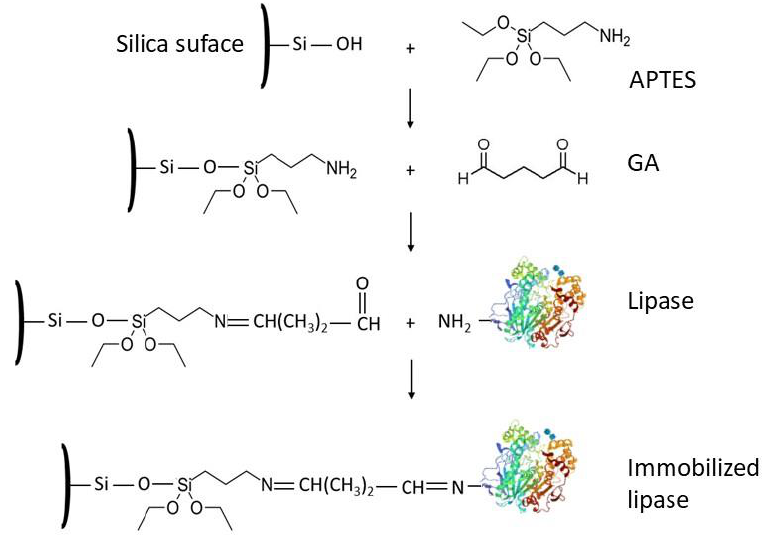
Figure 10. Lipase immobilization on epoxy-functionalized SBA-15. The application of magnetic nanoparticles in enzyme immobilization has received a great deal of attention due to the cheap and easy synthesis and better enzyme perfor- mance in recovery and reuse [114]. Core–shell structures of magnetic mesoporous silica that contain a superparamagnetic core and a large surface area provide an improved support system with high capacity and dispersion with external magnetic field [115]. Mehrasbi et al. [116] covalently immobilized lipase from Candida antarctica (CALB) on functionalized magnetic nanoparticles to catalyze biodiesel synthesis. Core–shell nano-